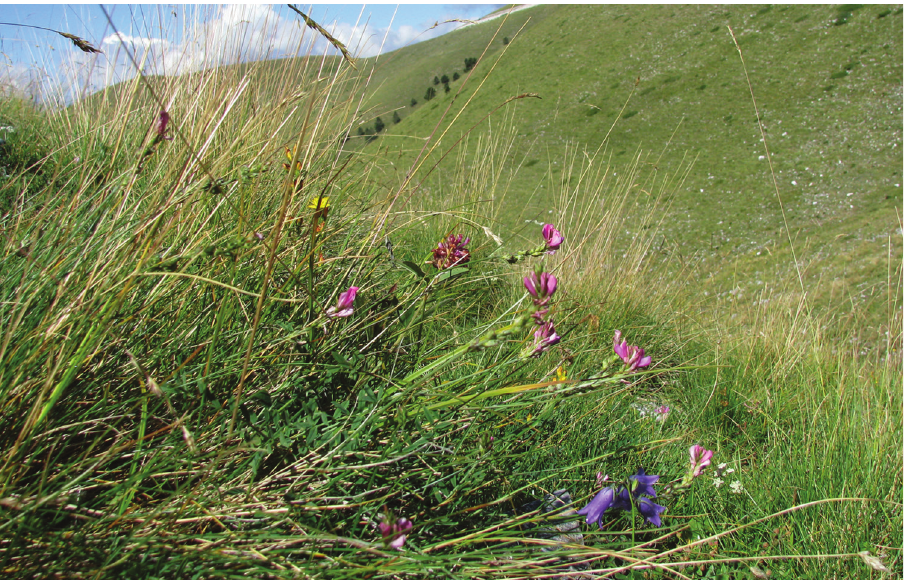
Figure 29. Habitat of P. nephohiptamenos . Northern Greece, Falakro Mt, near Granitis, 1700 m, 24 July 2008. Photo by V.A.